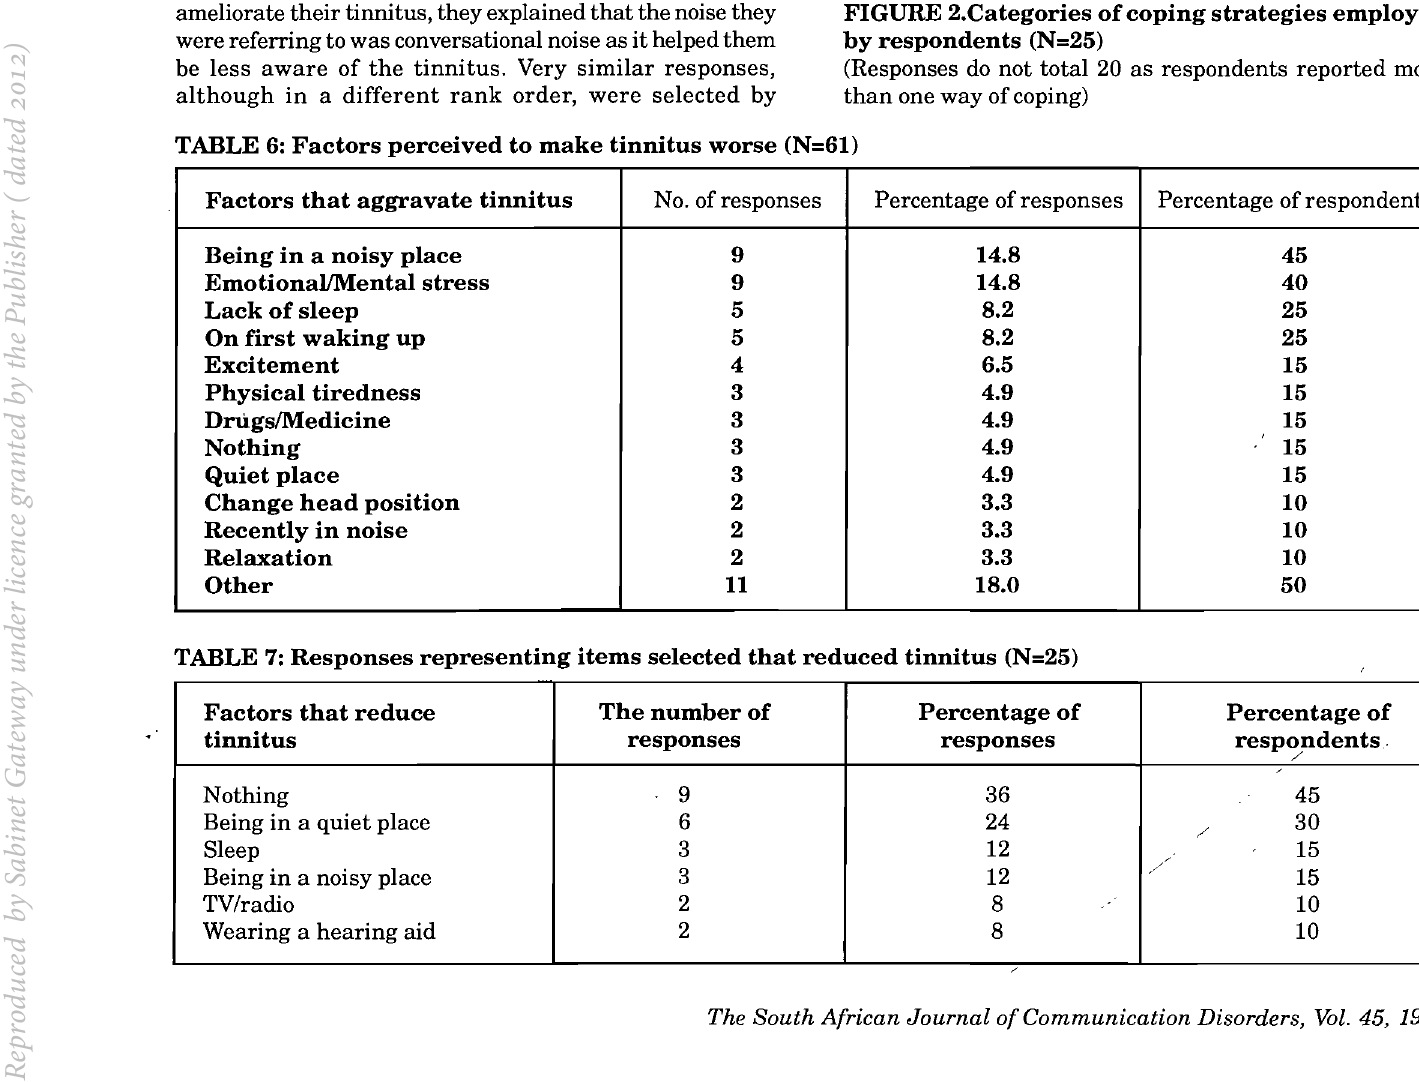
FIGURE 2.Categories of coping strategies employed by respondents (N=25) (Responses do not total 20 as respondents reported more than one way of coping)